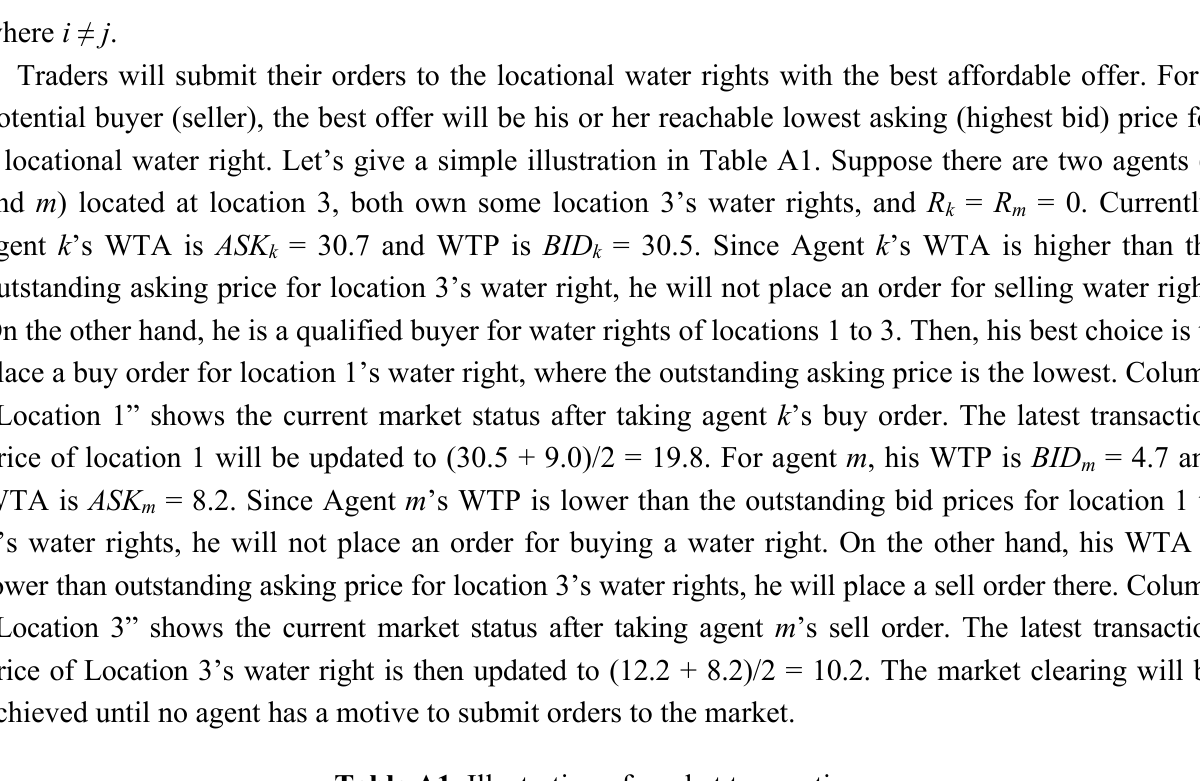
Table A1. Illustration of market